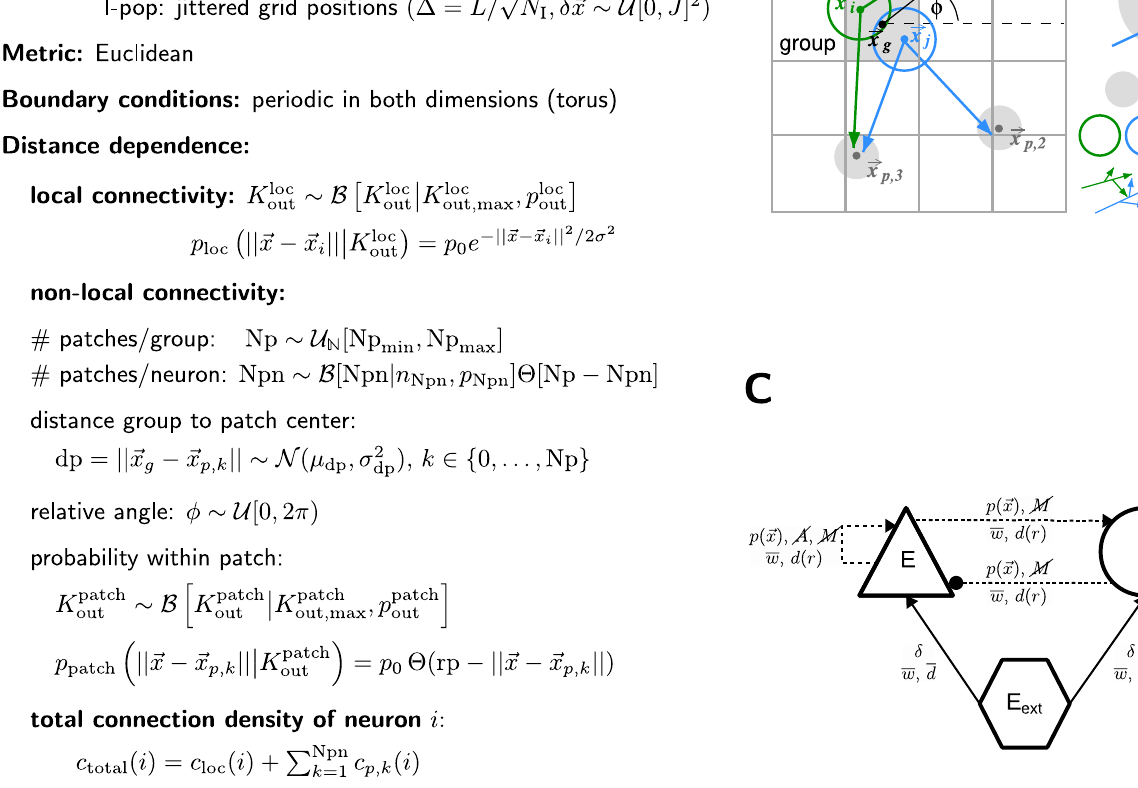
Fig 11. Two-dimensional spatial network with patchy long-range connections. (A) Spatial networks need to be defined in terms of dimension, layout, metric, boundary conditions, and the spatial or distance dependence of the connectivity, where applicable. In this example, neurons have both local and structured long-range connections [97]. Θ ( x ) = 0 if x < 0, 1 otherwise. (B) Sketch of patchy connectivity and parameters needed to define p patch . (C) Graphical notation of network connectivity corresponding to Fig 8.